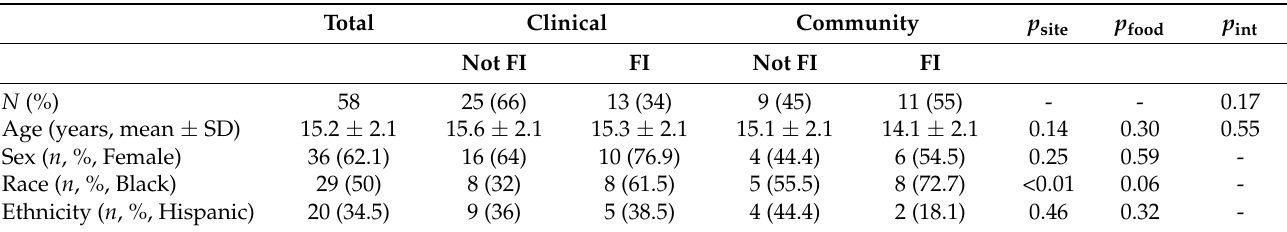
Table 1. Participant